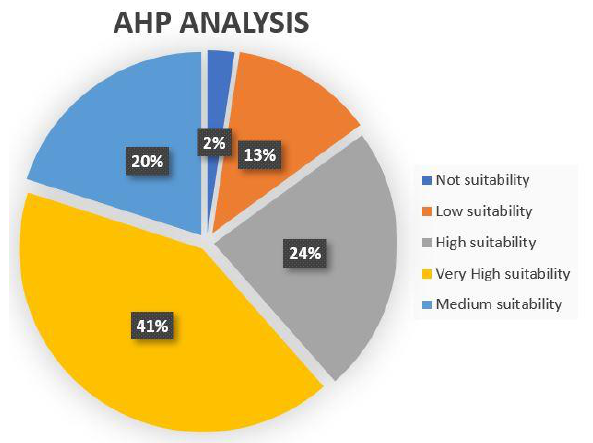
Figure 13 : Suitability